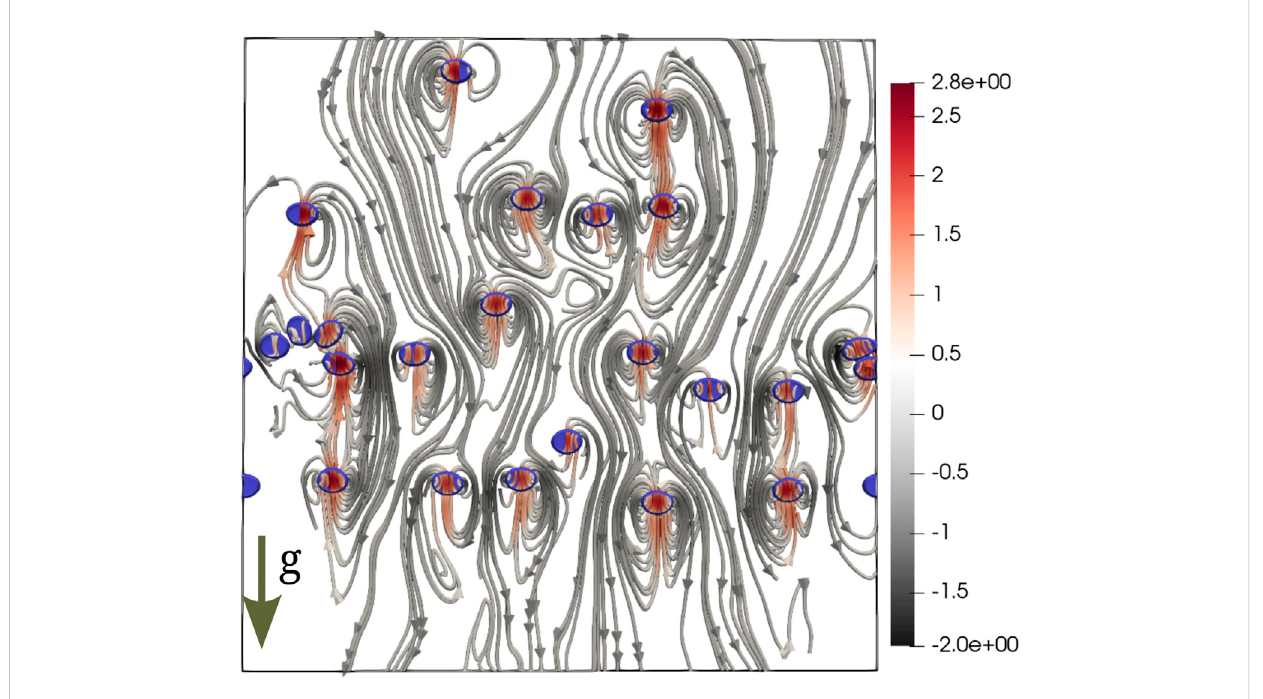
FIGURE 2 Instantaneous bubble con fi guration superimposed with fl ow streamlines in the steady-state (run H1 ). The streamlines are colored according to the z-component of the velocity.